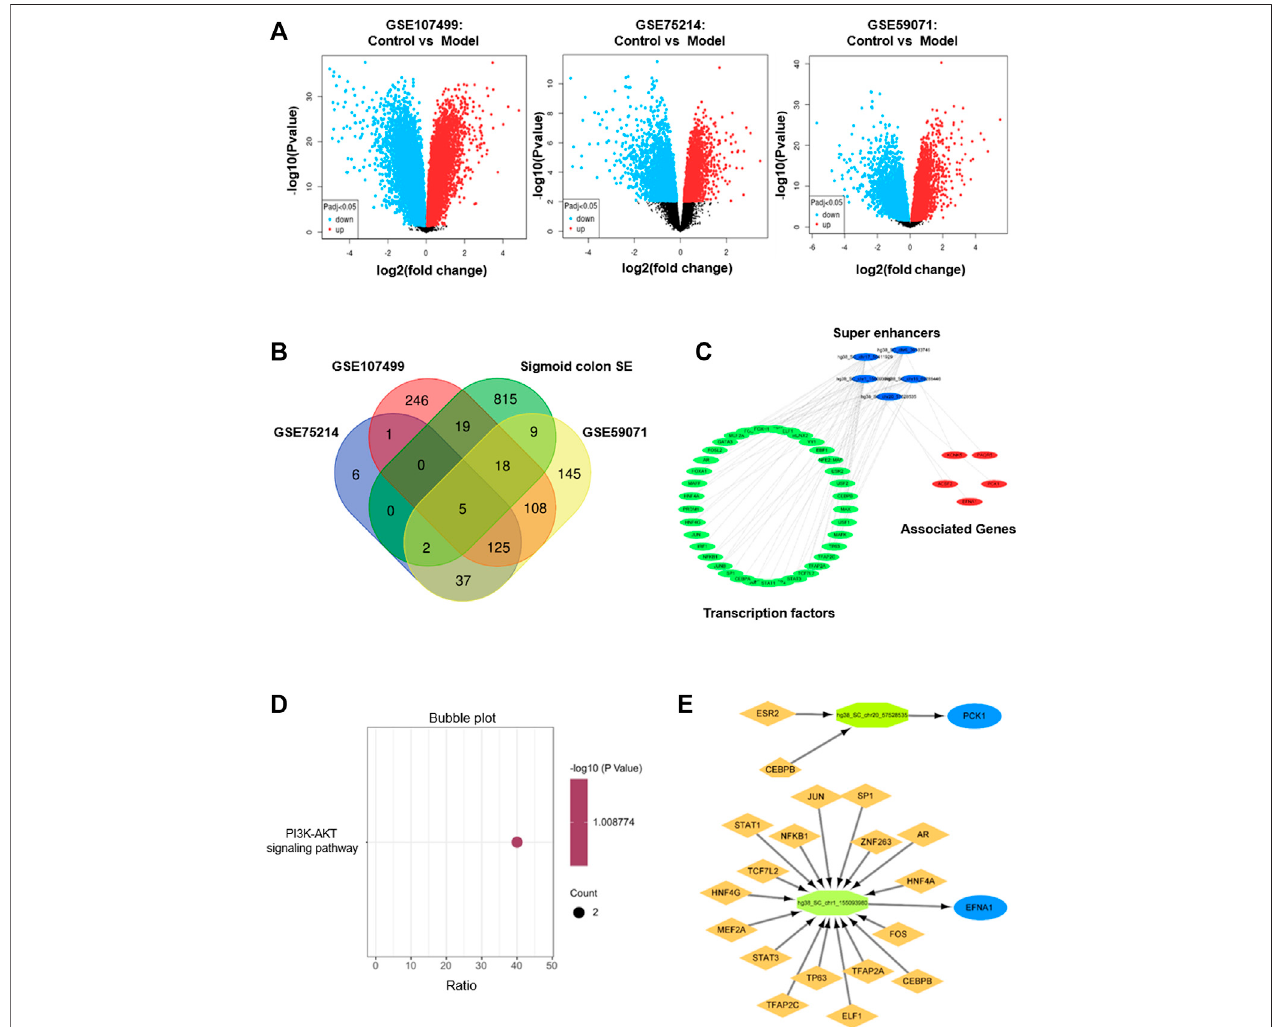
FIGURE1 | Identi fi cation ofpotentialpathogenic super-enhancer – driver genesin IBD. (A) Volcano diagram ofdifferentiallyexpressed genesbetween IBDpatients andnormalpeopleindatasetsGSE107499,GSE75214,andGSE59071intheGEOdatabase. (B) Venndiagramformedbycross-linkingofsuper-enhancer – associated genes and differentially expressed genes in dataset in in fl ammatory bowel disease. (C) Interaction network of TF, super-enhancer, and related genes in in fl ammatory bowel disease. (D) The KEGG pathway analysis. (E) TFs binding PCK1 and EFNA1 super-enhancers.